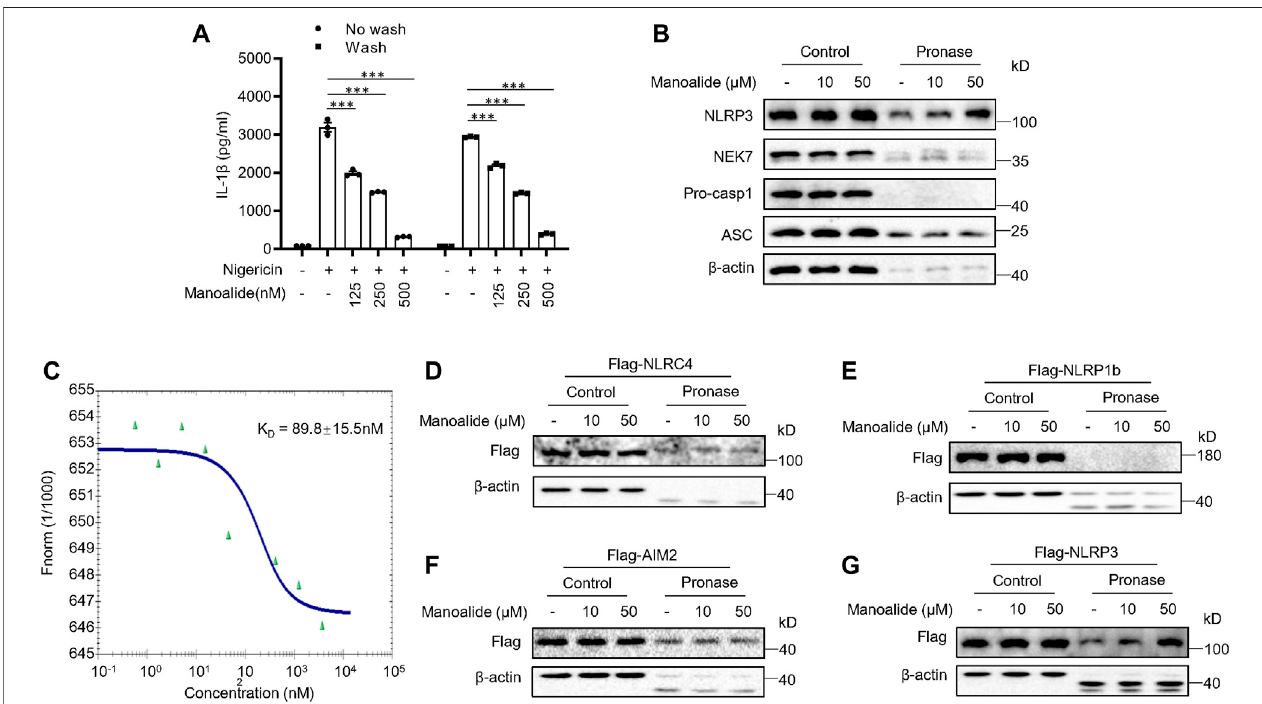
FIGURE 5 | Manoalide irreversibly binds to NLRP3. (A) ELISA of mature IL-1 β in the supernatant of LPS-primed BMDMs pretreated with 125, 250, 500 nM manoalide and then were washed three times before stimulation with nigericin. (B) DARTS analysis of NLRP3, NEK7, pro-caspase-1 and ASC in lysates from LPS- primed BMDMs incubated with 10, 50 μ M manoalide. (C) MST assay was performed to evaluate the af fi nity between manoalide with puri fi ed His-GFP-NLRP3. DARTS analysis of (D) Flag-NLRC4, (E) Flag-NLRP1b, (F) Flag-AIM2, (G) Flag-NLRP3 from lysates of HEK-293T cells transfected with indicated plasmids in the presence or absence of 10, 50 μ M manoalide. Data are derived from three independent experiments (A) and displayed as mean and SEM ( n = 3) or represent three independent experiments (B-G) . Statistically signi fi cant difference was calculated by unpaired Student ’ s t-test: *** p < 0.001.